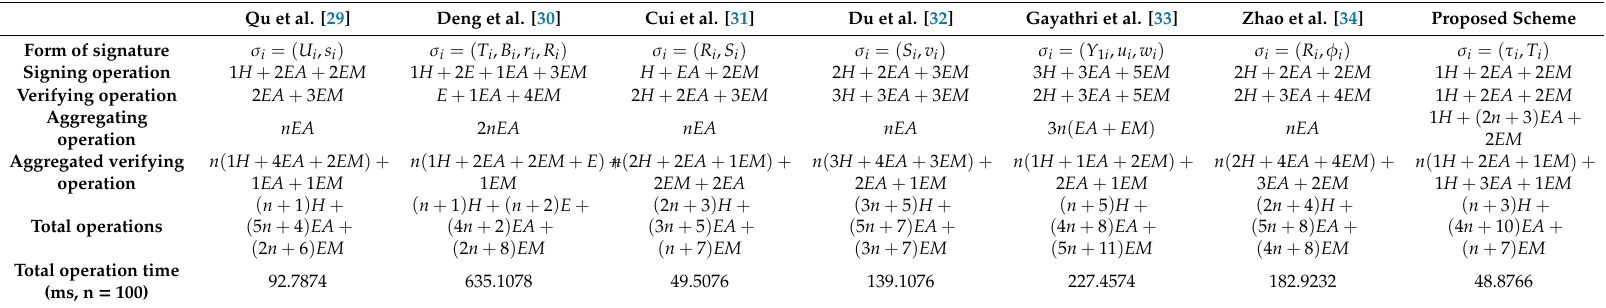
Table 3. E ffi ciency analysis of the proposed